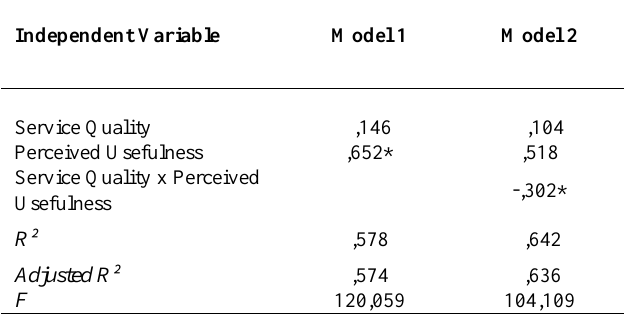
Table 5: Multiple regression analysis of perceived usefulness as a moderator